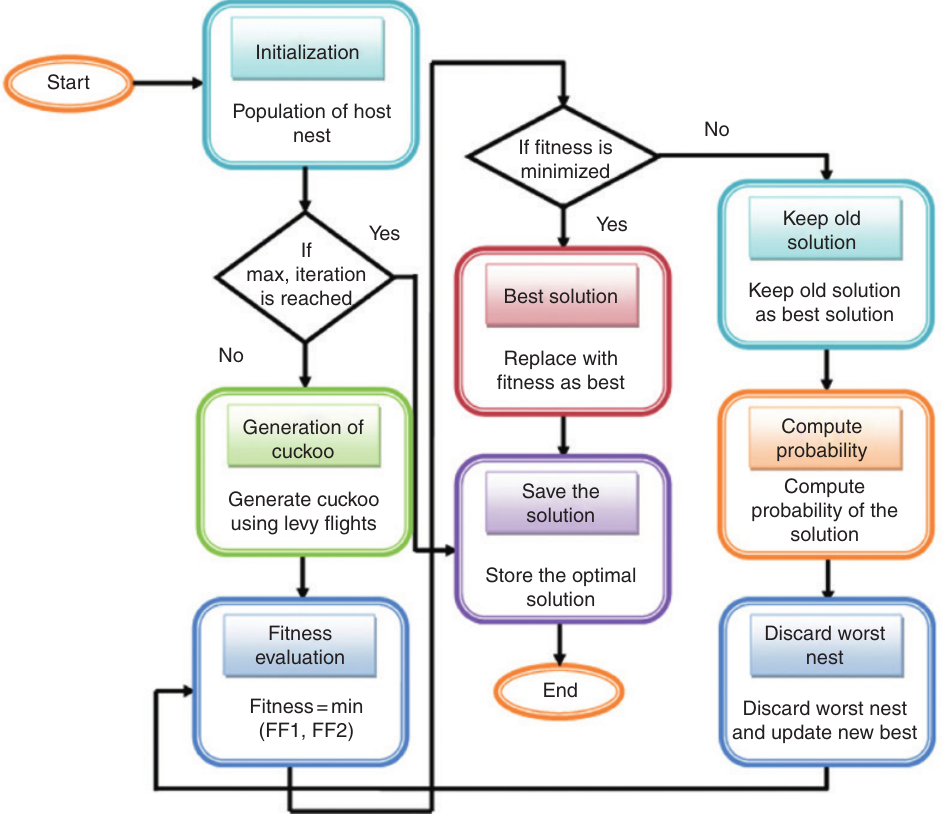
Figure 2: Flowchart of the CS